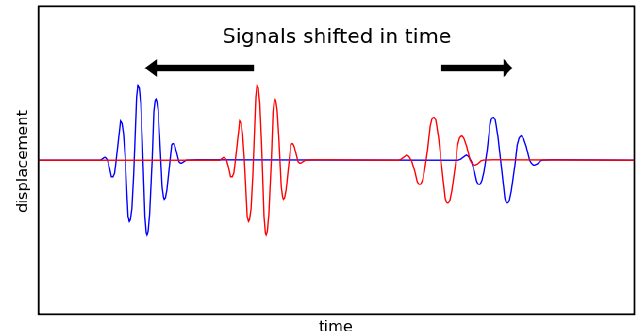
Fig. 3. Diagram showing how parts of a waveform are time shifted to overlay matching parts of the waveform being compared.